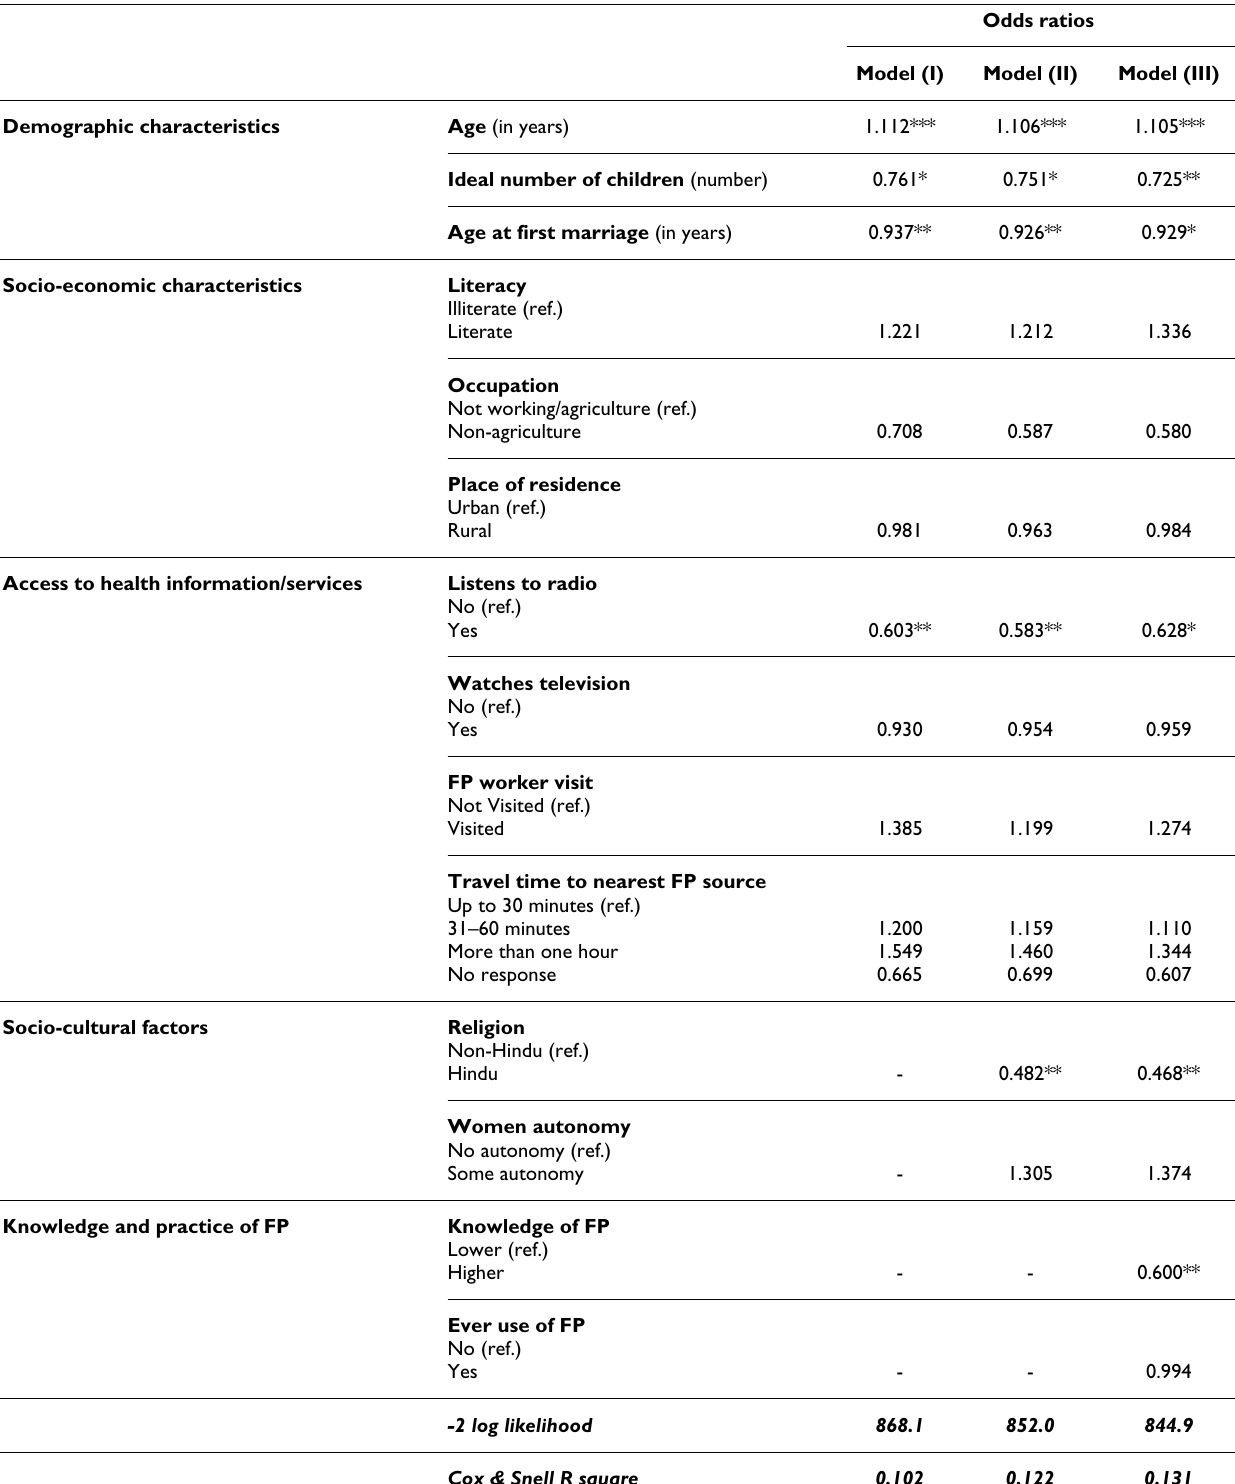
Table 3: Estimated odds ratios for having unintended pregnancy among currently pregnant married women by selected